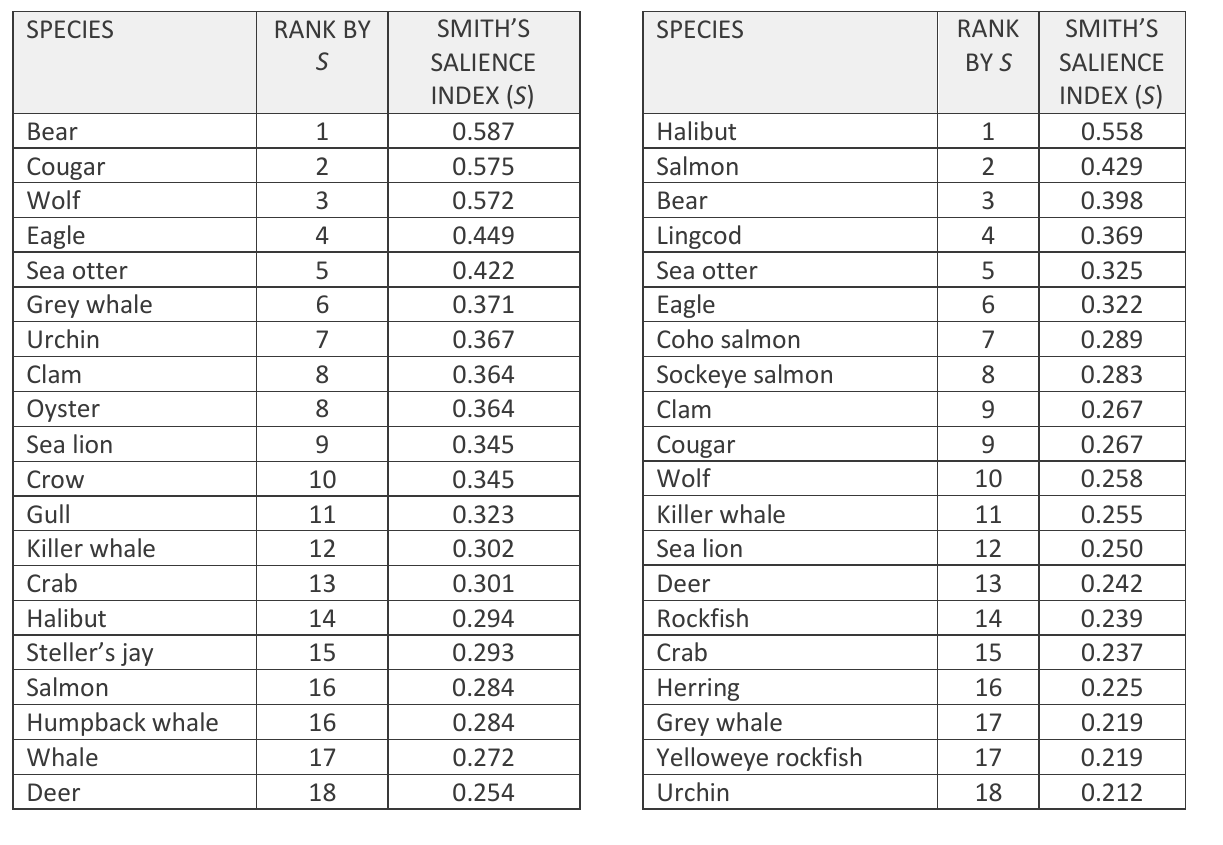
Table (cid:4)(cid:1008) .4 Most cognitively accessible species: males (top